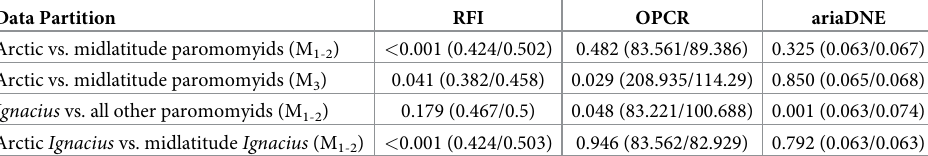
Table 4. Results (p-values) of t-tests comparing dental topography metrics of paromomyid molars.